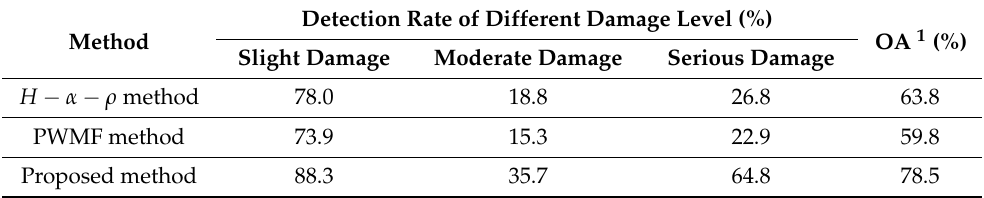
Table 9. Accuracy evaluation results of damage maps from different methods in Mashiki town.